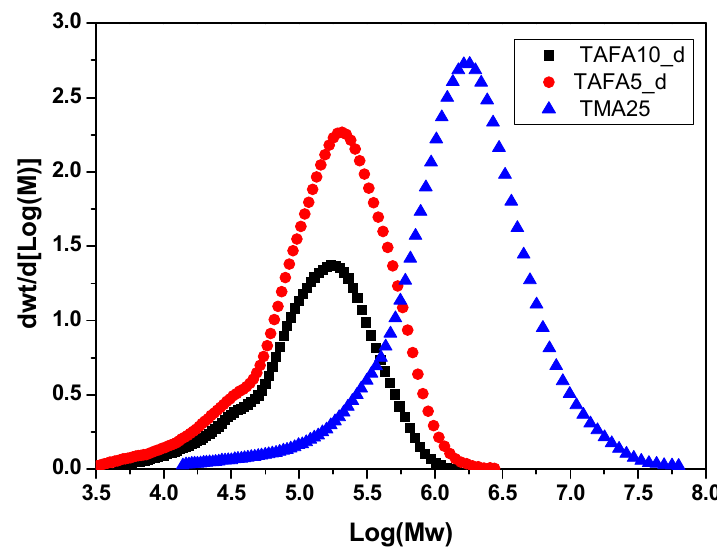
Figure 5. Molar mass distribution of MMA/VPi/MA terpolymer (TMA25), MMA/VPi/AFA terpolymer with 5 wt% of acrylated fatty acids (TAFA5_d), and MMA/VPi/AFA terpolymer with 10 wt% of acrylated fatty acids (TAFA10_d).